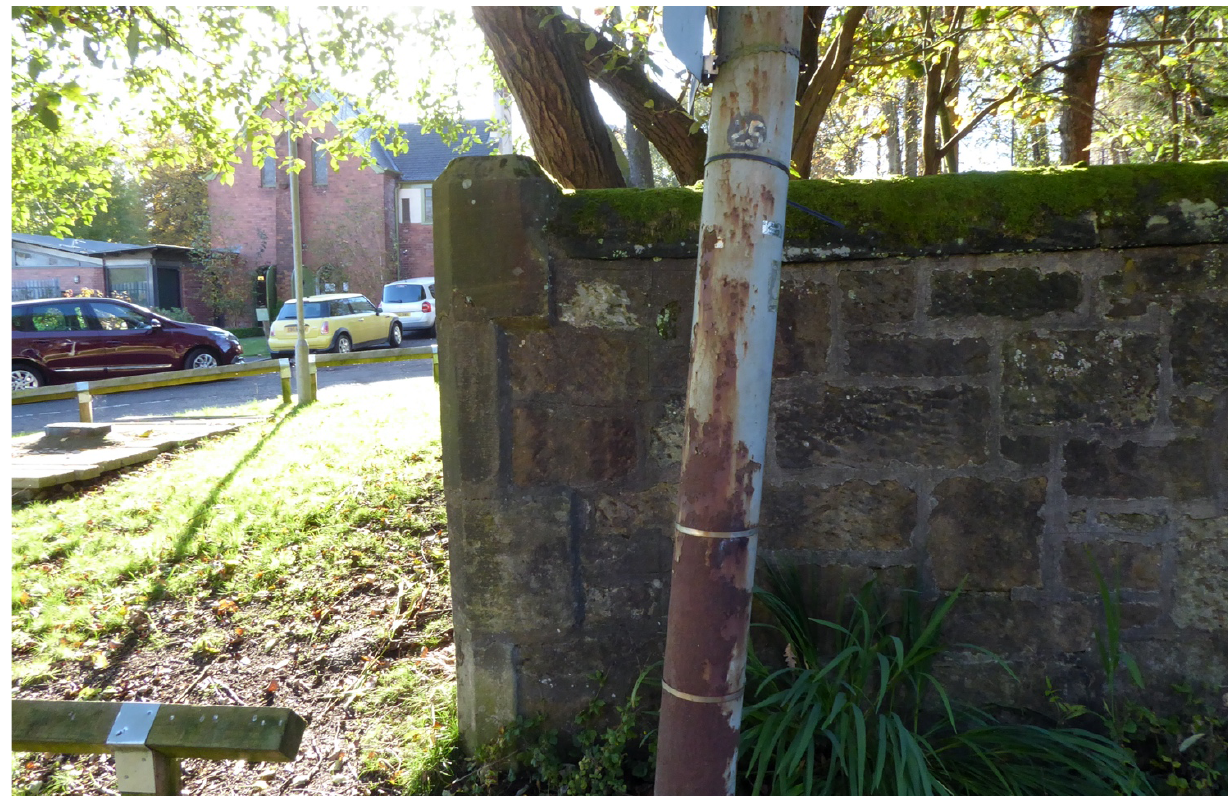
Figure 1. The perimeter wall once constructed to enclose the entire grounds of Gartnavel Royal Hospital. Source: Ebba